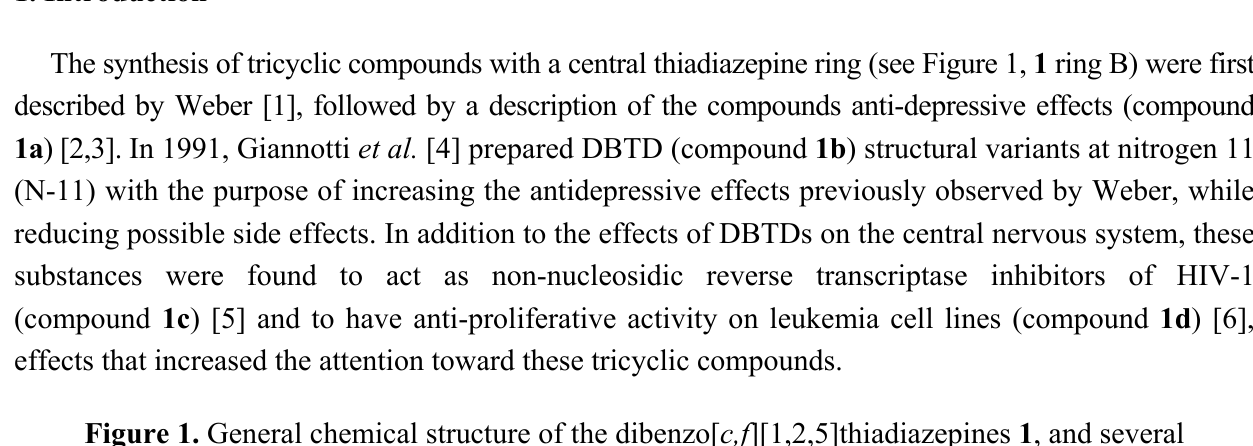
Figure 1. General chemical structure of the dibenzo[ c,f ][1,2,5]thiadiazepines 1 , and several DBTDs reported to have biological activity (compounds 1a , 1b , 1c , and 1d